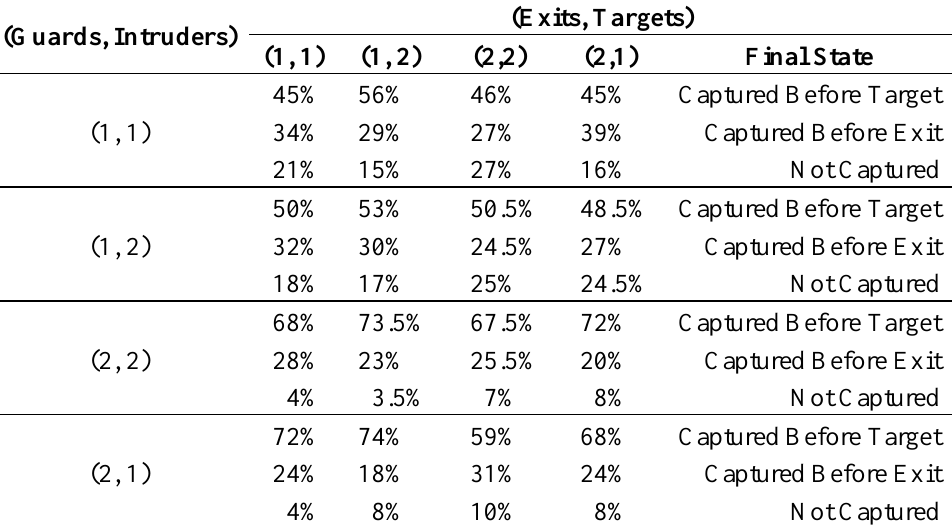
Table 2. Results of the test that simulated the system behaviour beginning from different starting configurations ( Guards, Intruders, Exits, Targets